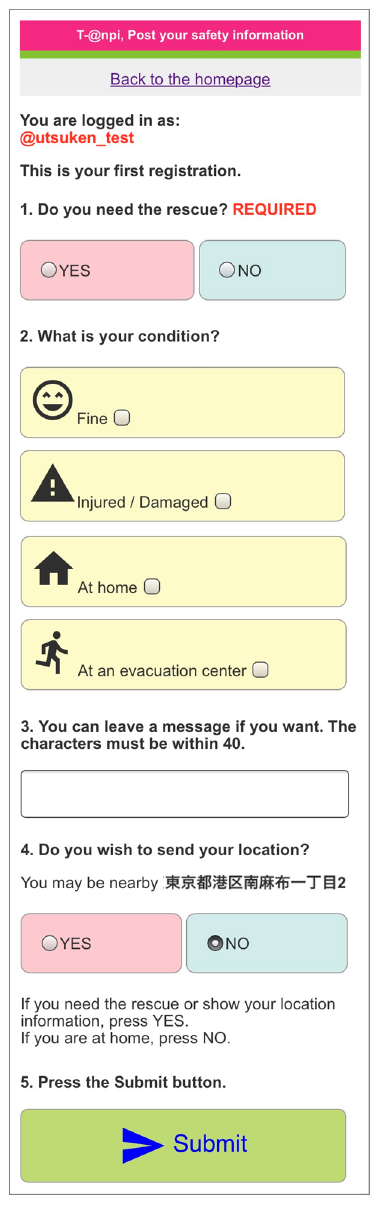
Figure 4. Registration page of safety information presented to the sending user.